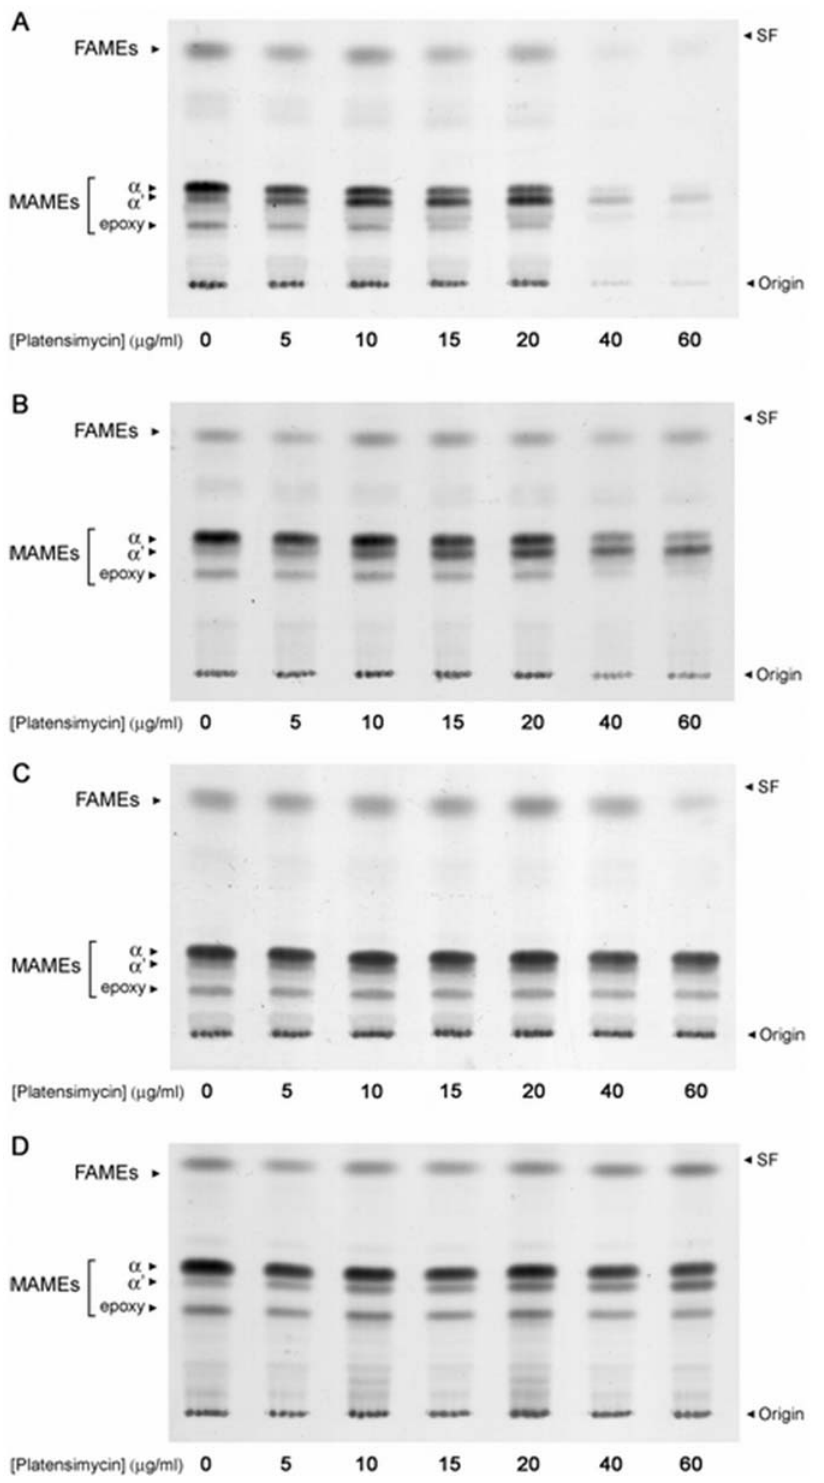
Figure 5. TLC-autoradiography of FAMEs and MAMEs from M.smegmatis strains overexpressing Mt-KasA, Mt-KasB and Mt-FabH following platensimycin treatment. Platensimycin (0–60 m g/ml) was titred into M. smegmatis cultures at an OD 600 nm of 0.4 prior to labelling with 1 m Ci/ml [1,2- 14 C]acetate for 12 h. [ 14 C]-FAMEs and MAMEs were extracted and resolved by TLC. An equivalent aliquot of the resulting solution of FAMEs and MAMEs was subjected to TLC using silica gel plates developed twice in petroleum ether-acetone (95:5). Autoradiograms were produced by overnight exposure to Kodak X-Omat film to reveal [ 14 C]labeled FAMEs and MAMEs. (A) M. smegmatis pVV16, (B) M. smegmatis pVV16-Mt-KasA, (C) M. smegmatis pVV16-Mt-KasB, and (D) M. smegmatis pVV16-Mt-KasAB.